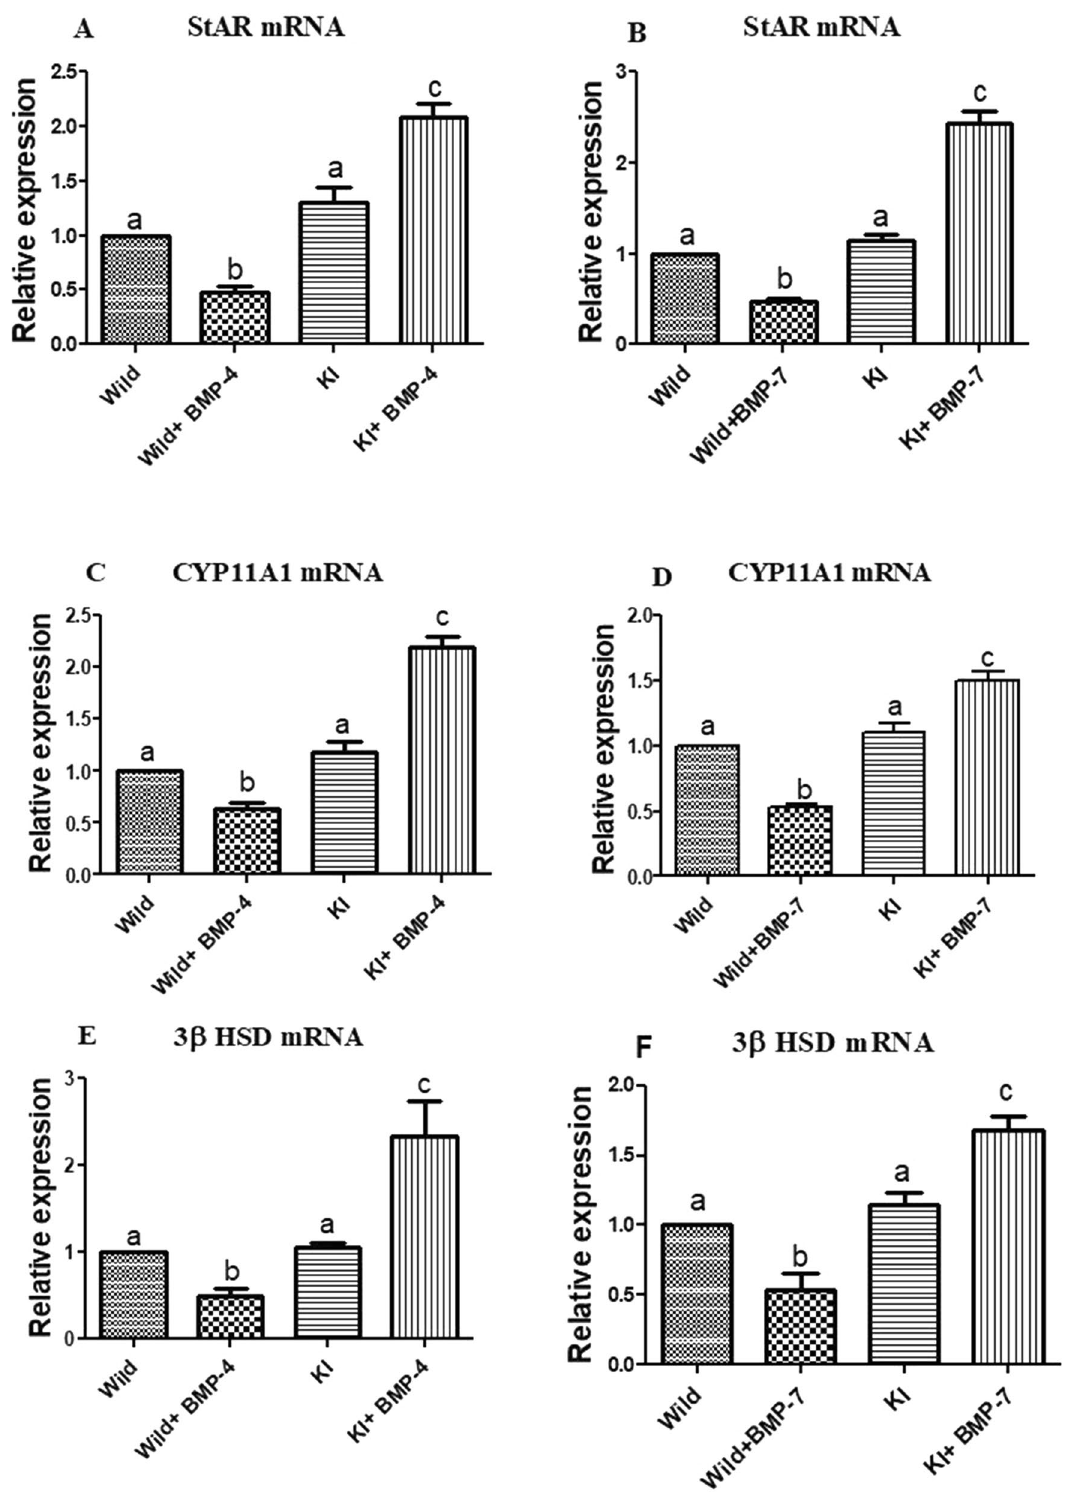
Figure 7. Effect of BMPR-IB gene KI on expression of StAR, CYP11A1 and 3βHSD genes in in vitro cultured granulosa cells stimulated with BMP-4 (50 ng/ml) or BMP-7 (100 ng/ml) for 72 h. All values are shown as mean ± SEM. Different superscripts denote statistically different values ( p < 0.05). Abbreviations: WT indicate wild type cells, WT + BMP-4/BMP-7 indicate wild cells treated with BMP-4 (50 ng/mL), KI indicate BMPR-IB gene knock out cells. KI + BMP-4/BMP-7 indicate KI cells treated with BMP-4(50 ng/ml) or BMP-7 (100